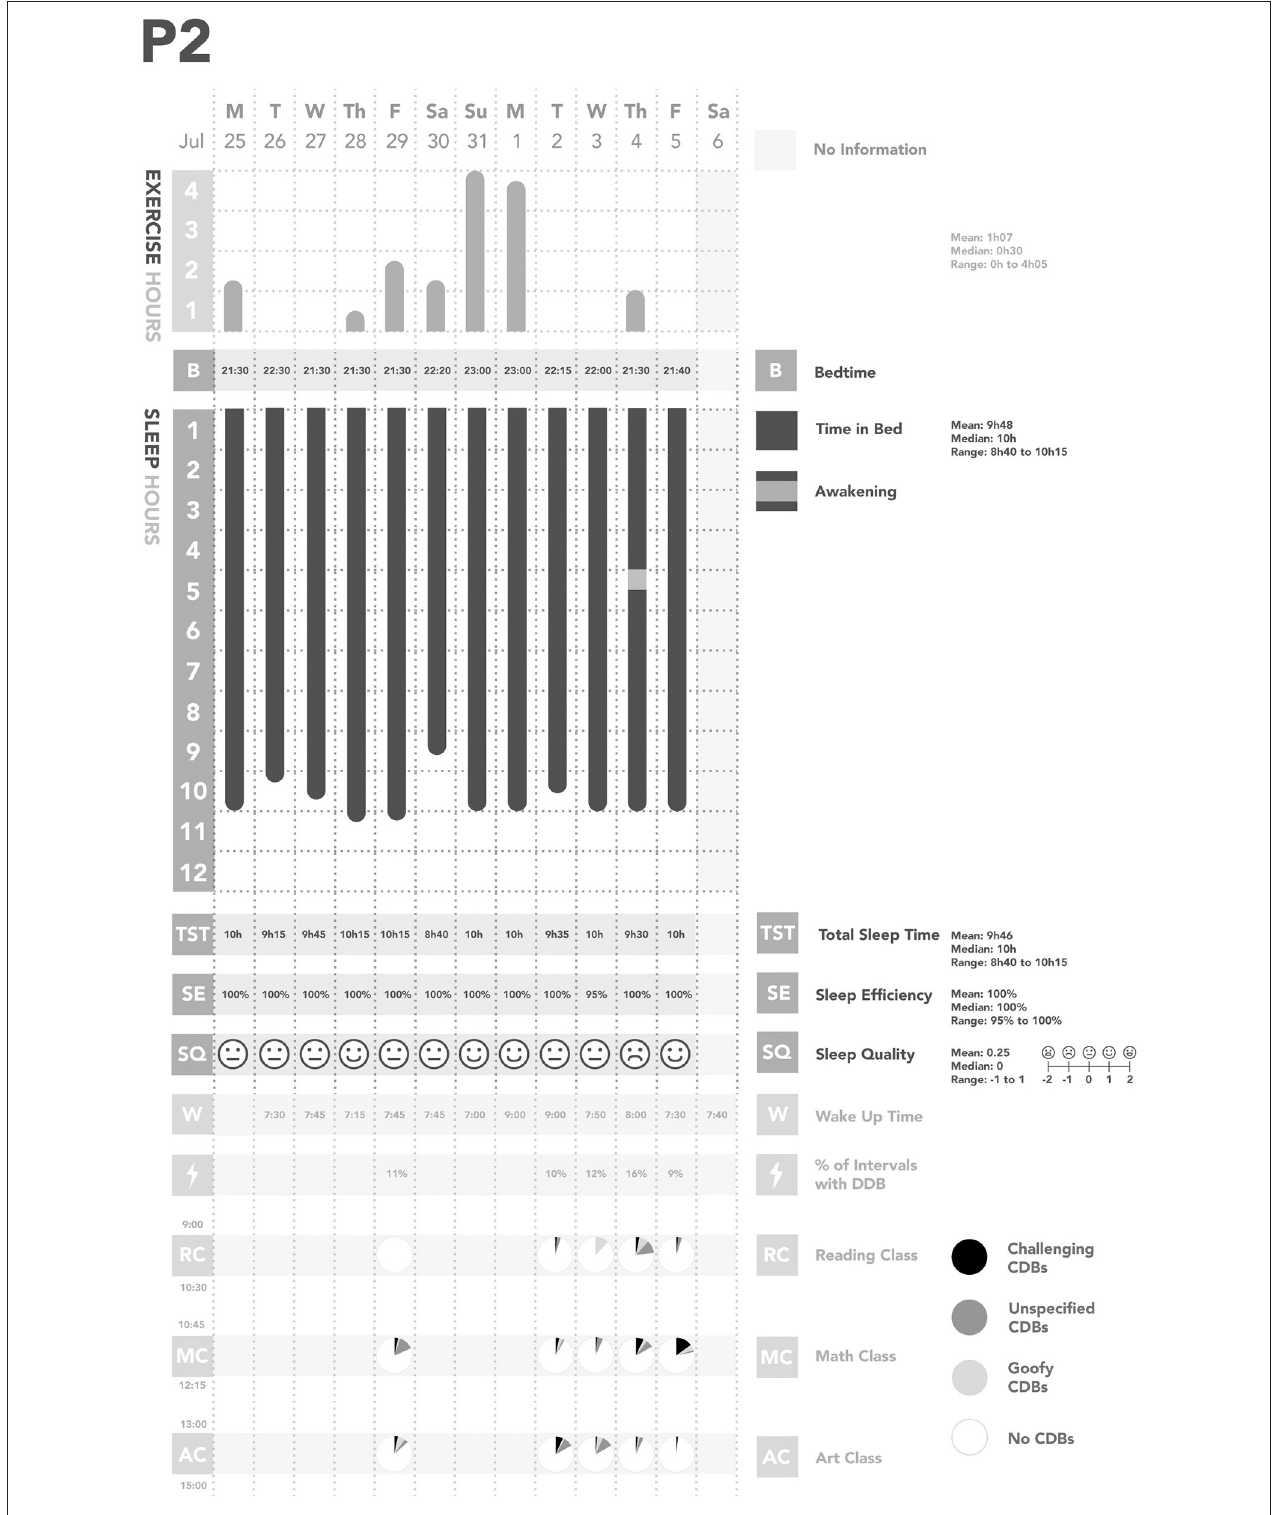
FIGURE 2 | Summary of Participant 2 (P2)’s data. CDBs, Challenging and/or disruptive behaviors.